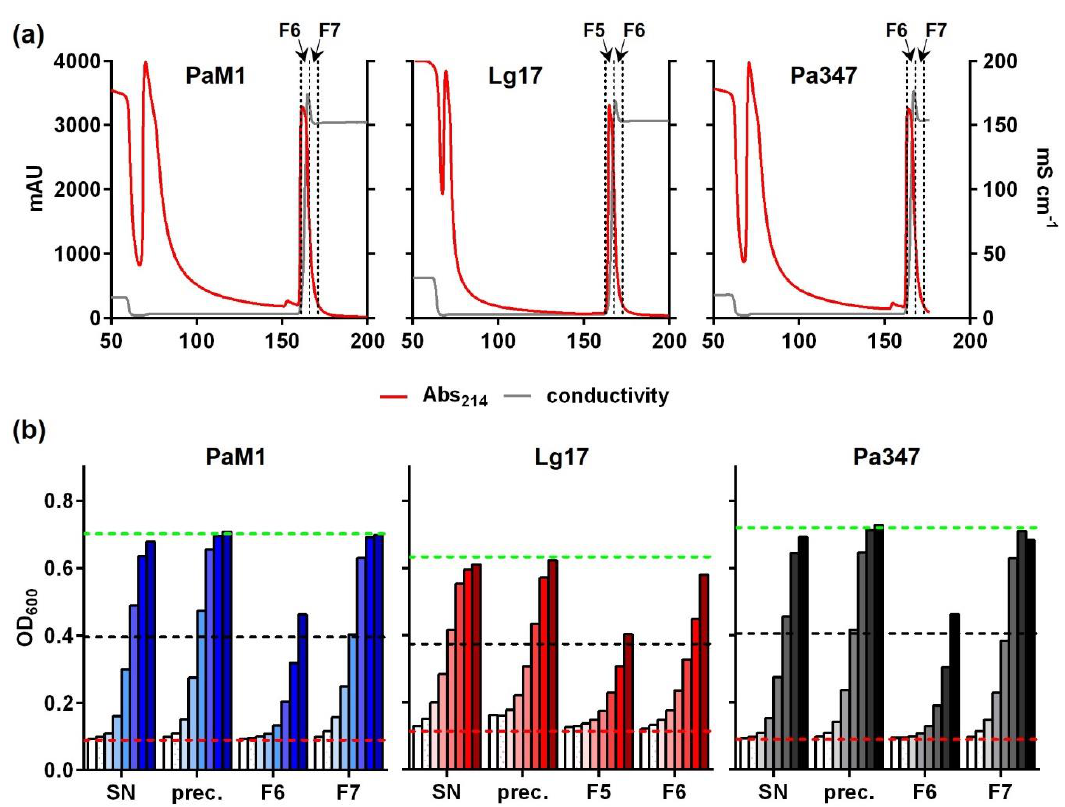
Figure 4. ( a ) Cation exchange chromatography of ammonium sulfate precipitated supernatant proteins of P. acidilactici M1 (PaM1), L. garvieae 17 (Lg17), and P. acidilactici 347 (Pa347) following growth in MRS medium. Red lines indicate absorbance at 214 nm in milli arbitrary units (mAU) and grey lines the conductivity in mS/cm. Broken vertical lines indicate the boundaries of fractions F6 and F7 of the eluate collected for further analysis. ( b ) Inhibition of growth of L. monocytogenes EGDe/pNZ-P help -pHluorin by 2-fold serial dilutions of different steps of the purification of antimicrobial compounds of P. acidilactici M1 (PaM1), L. garvieae 17 (Lg17), and P. acidilactici 347 (Pa347). SN: spent culture supernatants; prec: ammonium sulfate-precipitated supernatant proteins; F5, F6, F7: fractions 5, 6, or 7 of the elution step of cation exchange chromatography of precipitated supernatant proteins shown in ( a ). Dilutions were 1:16–1:2048 and are indicated by a color scale with increasing intensity. Values are OD 600 of the indicator strain and are mean ± standard deviation of duplicate measurements of one representative preparation for each strain. The broken red and green lines indicate OD 600 of the positive (i.e., complete inhibition of growth) or negative (i.e., sterile MRS medium) controls, respectively. The broken black lines represent growth inhibition of 50% (i.e., the threshold to calculate bacteriocin